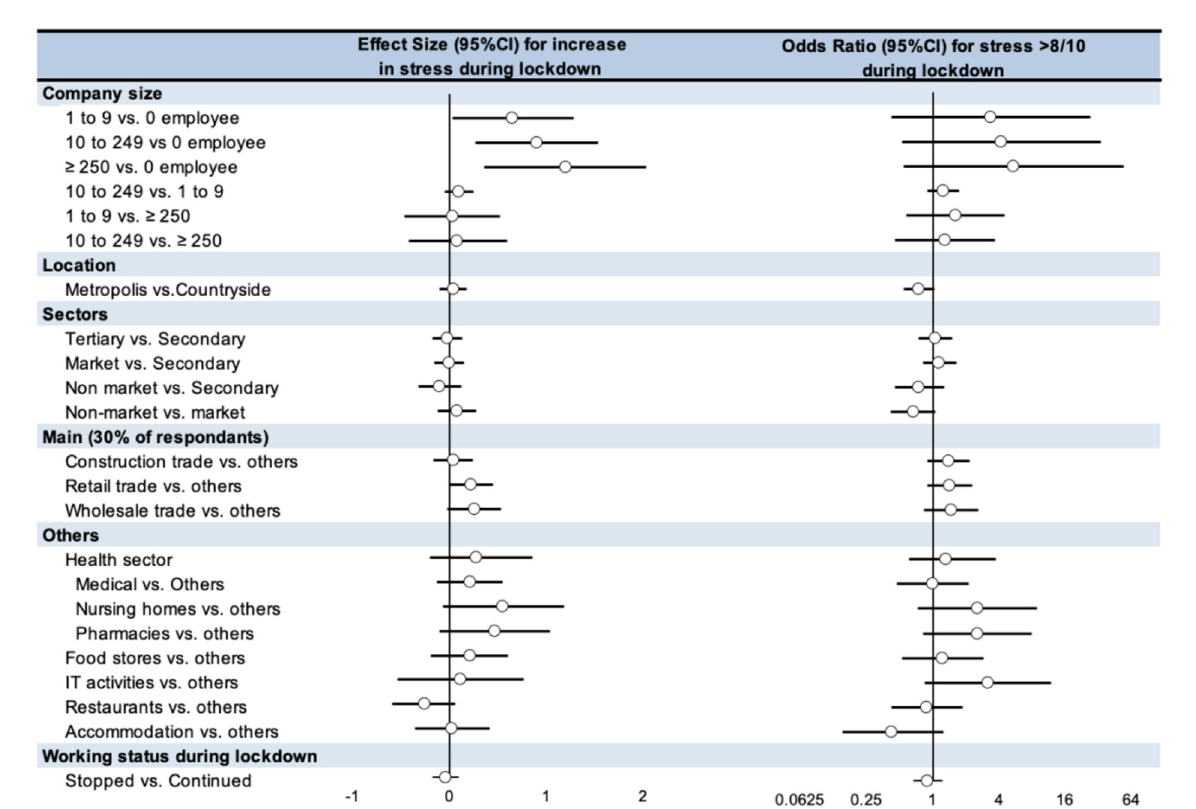
FIGURE5 Factors influencing the increase in stress levels and risk for stress > 8/10 (Odds Ratio) during lockdown. 95%CI, 95% Confidence